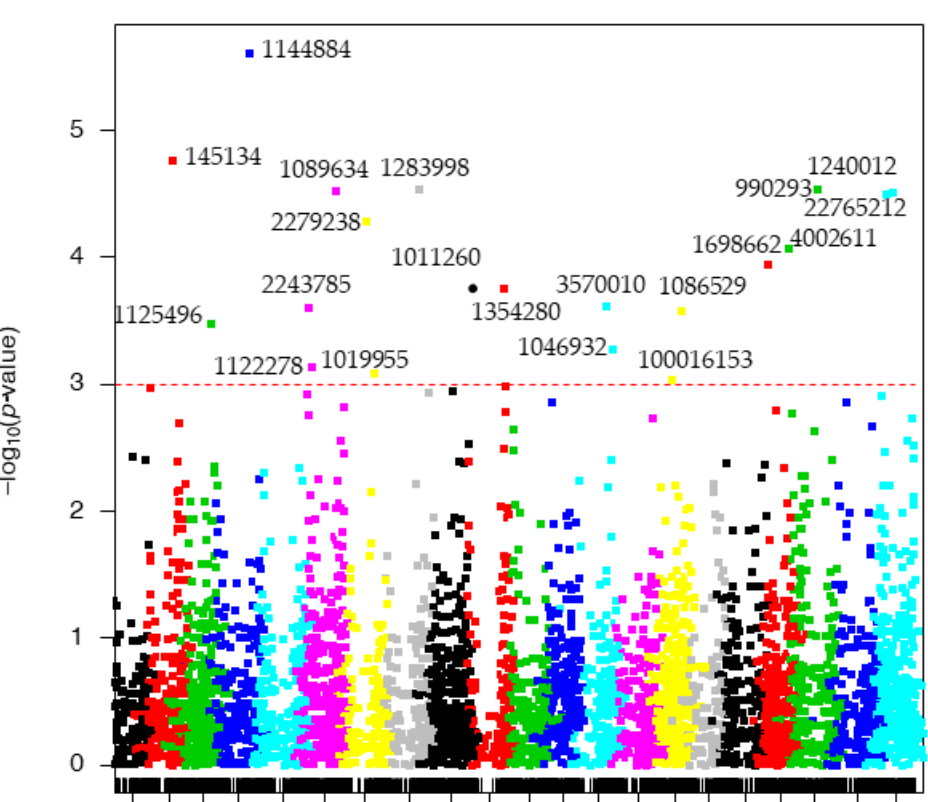
Figure 2. Manhattan plots for spot blotch (SB) disease corresponding to the physical position of Chinese spring Ref Seq ver.1.0. The p -values are shown on a log 10 scale. The marker is considered significant if log 10 scale is 3 or higher.